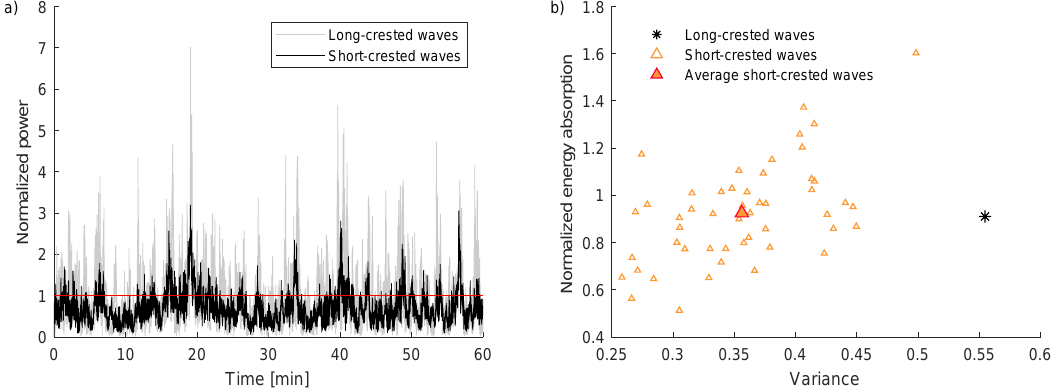
Figure 9. Performance of a wave energy park of 16 devices in long-crested, unidirectional waves, as compared to short-crested waves. The short-crested waves are composed of waves travelling in 15 directions with spreading function s = 5, corresponding to the directional spreading function and surface elevation shown in Figure 4b. ( a ) power for the full park in long-crested and short-crested irregular waves. The power has been divided by N · ¯ P i to be displayed in terms of the normalized isolated power. For clarity, q = 1 is highlighted with a red line; ( b ) normalized energy absorption versus variance for the long-crested and short-crested waves, respectively. The average values for all the 50 simulations of short-crested waves is highlighted with a filled